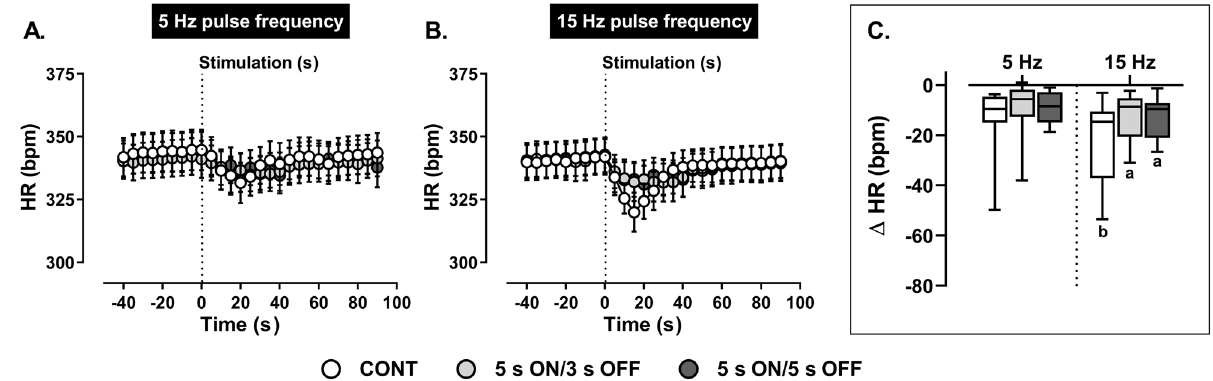
Figure 4. Effect of ( A ) low (5 Hz) and ( B ) high (15 Hz) frequency continuous (CONT) versus intermittent (5 s ON/3 s OFF and 5 s ON/5 s OFF) aortic depressor nerve (ADN) stimulation (0.4 mA, 0.2 ms for 20 s) on reflex reductions in mean heart rate (HR) in pentobarbital-anesthetized spontaneously hypertensive rats (SHRs). ( A,B ) The time trend for the reflex bradycardic responses to ADN stimulation, while ( C ) shows absolute changes (bpm) in HR in response to ADN stimulation. Results are expressed as mean ± SEM ( n = 8), analyzed by a two-way ANOVA followed by followed by Bonferroni’s post hoc test. a: P < 0.05 versus continuous stimulation for each frequency and b: P < 0.05 versus respective stimulation across